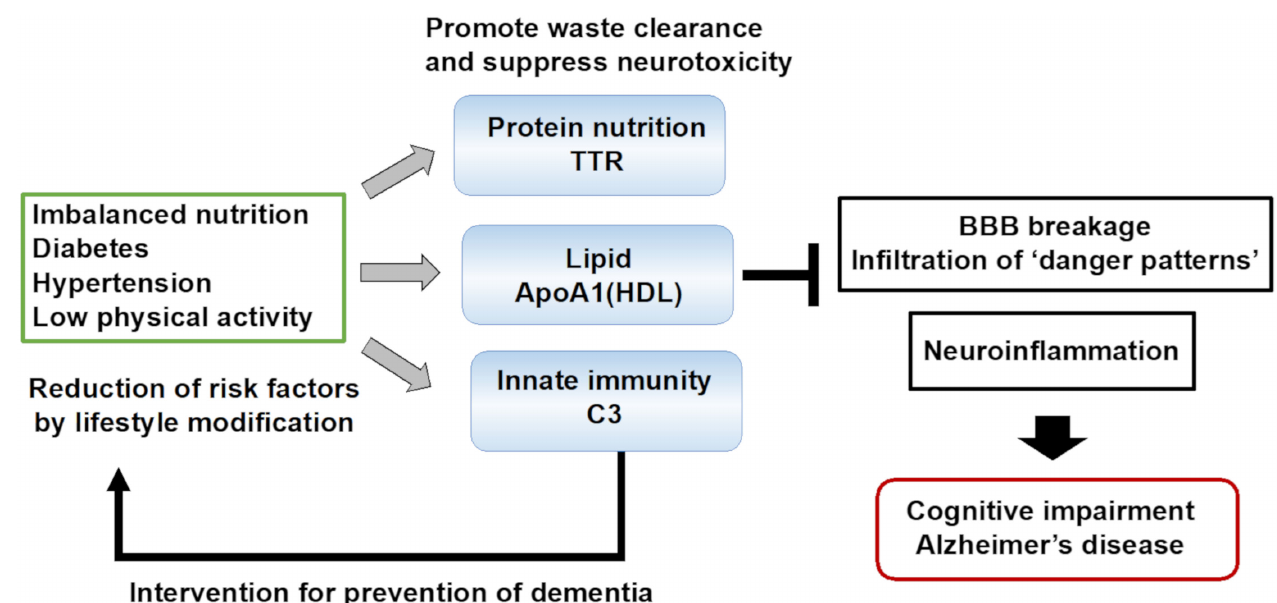
Figure 2. Possible roles of blood biomarker proteins in dementia